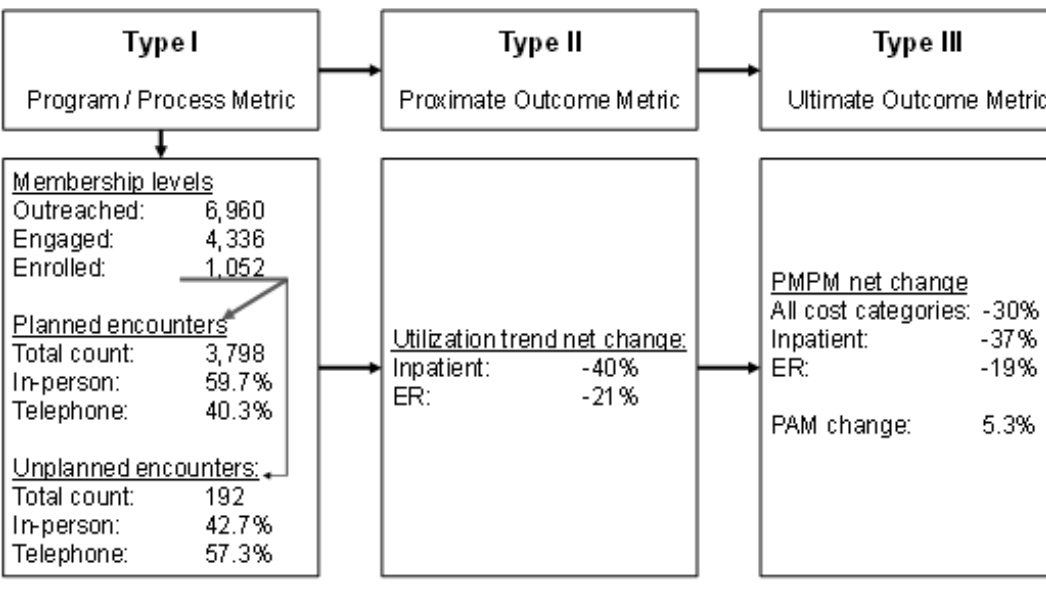
PAM: patient activation measure; PMPM: per member per